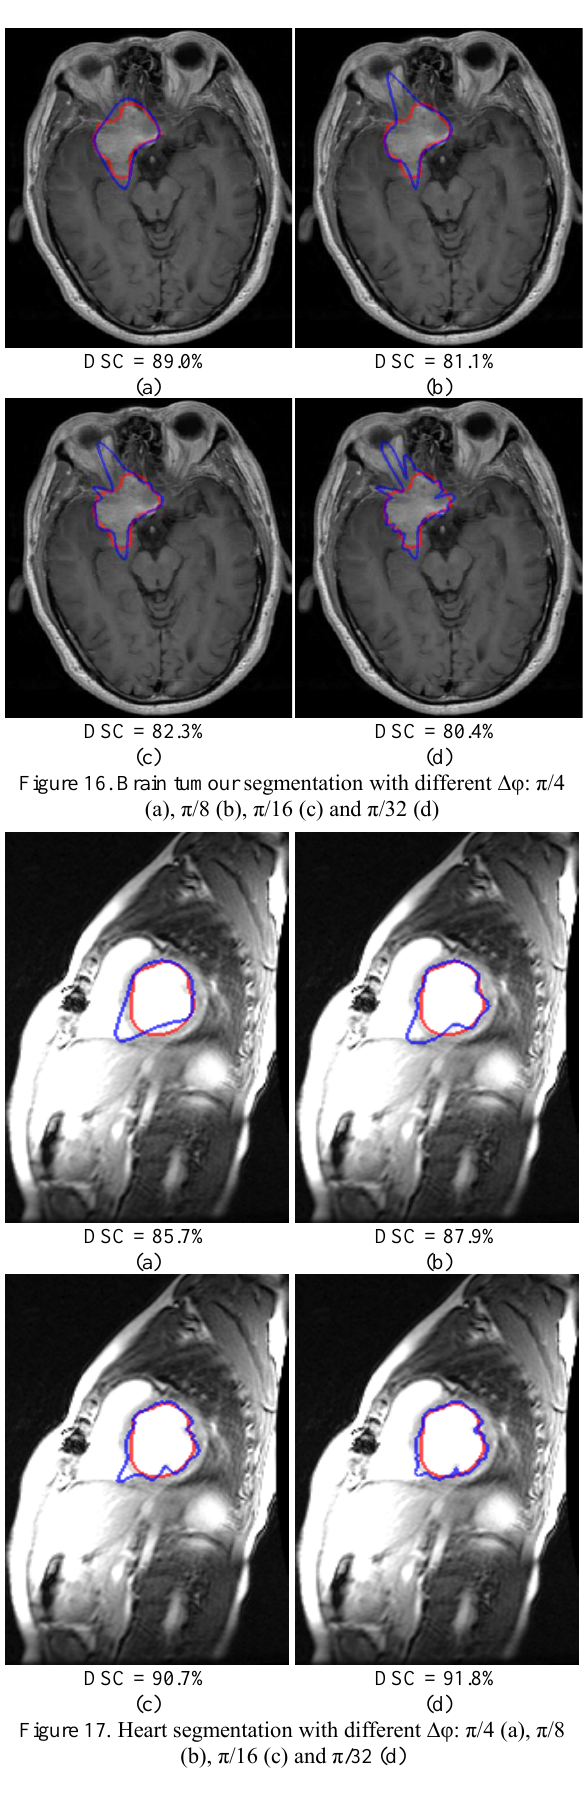
Figure 17. Heart segmentation with different ∆φ: π/4 (a), π/8 (b), π/16 (c) and π/32